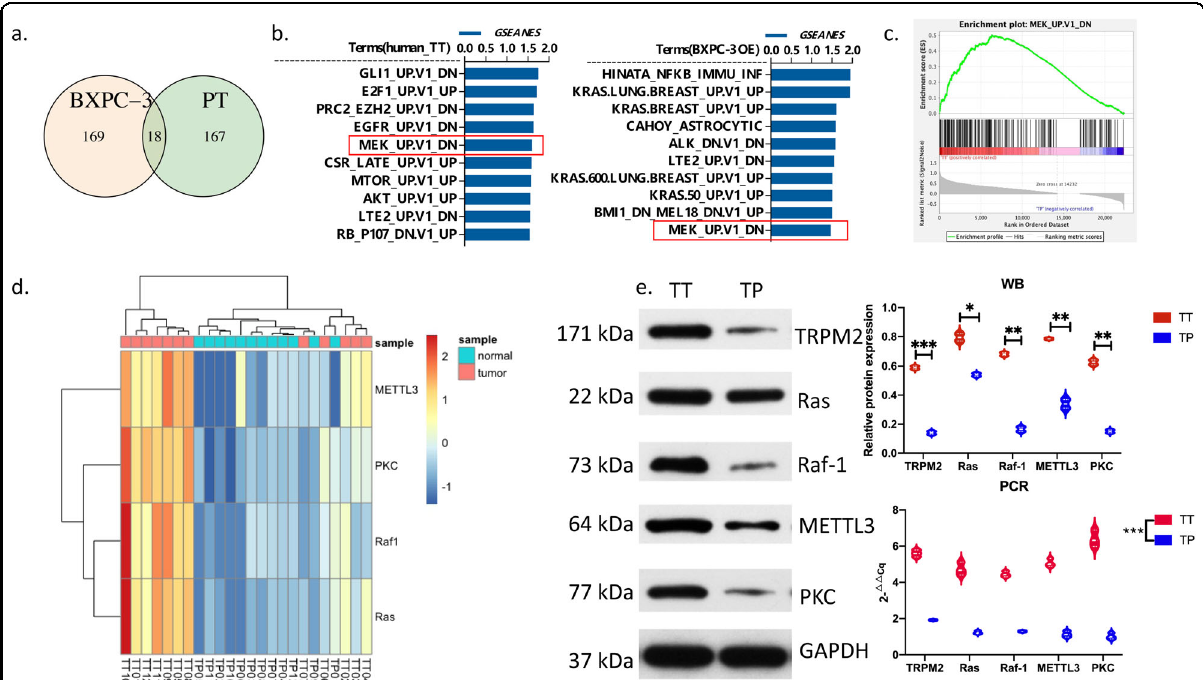
Fig. 5 TRPM2 could promote pancreatic cancer through PKC/MEK pathway. a Venn graph showed the intersection of signal pathways enriched in tumors of nude mice and human. b Top ten standard NES of TT vs. TP in patients and OE vs. NC in nude mice; c GSEA analysis of enrichment plot of MEK pathway. d Screening of key genes of the MEK pathway signaling pathway in TT vs. TP groups (12 samples each for TT or TP group). e Using western blot and qPCR to verify the expression of MAPK/MEK key molecules in patient ’ s TT and TP groups (* P < 0.05, ** P < 0.01, *** P < 0.001, **** P < 0.0001, 12 samples each for TT or TP